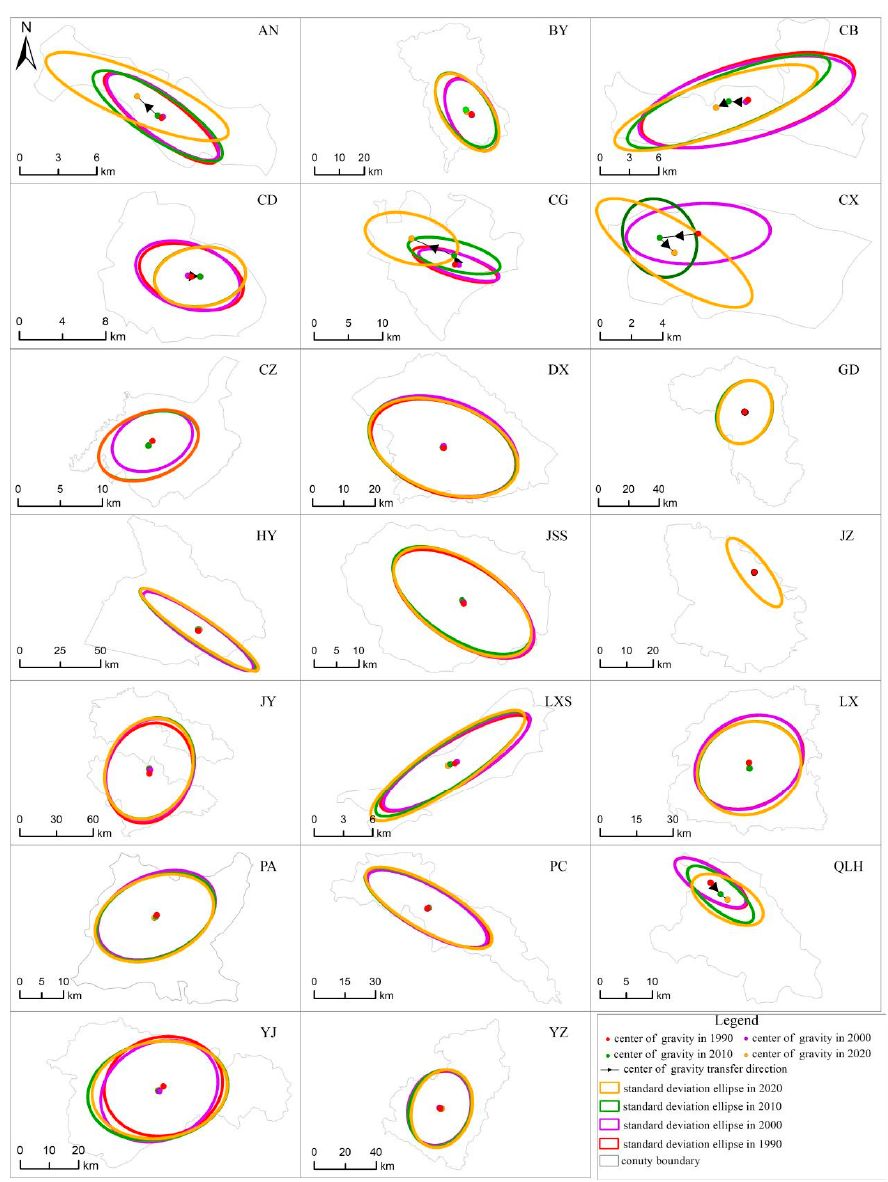
Figure 7. Distributions of the central rural residential land shifts at the county level in the study area from 1990 to 2020.